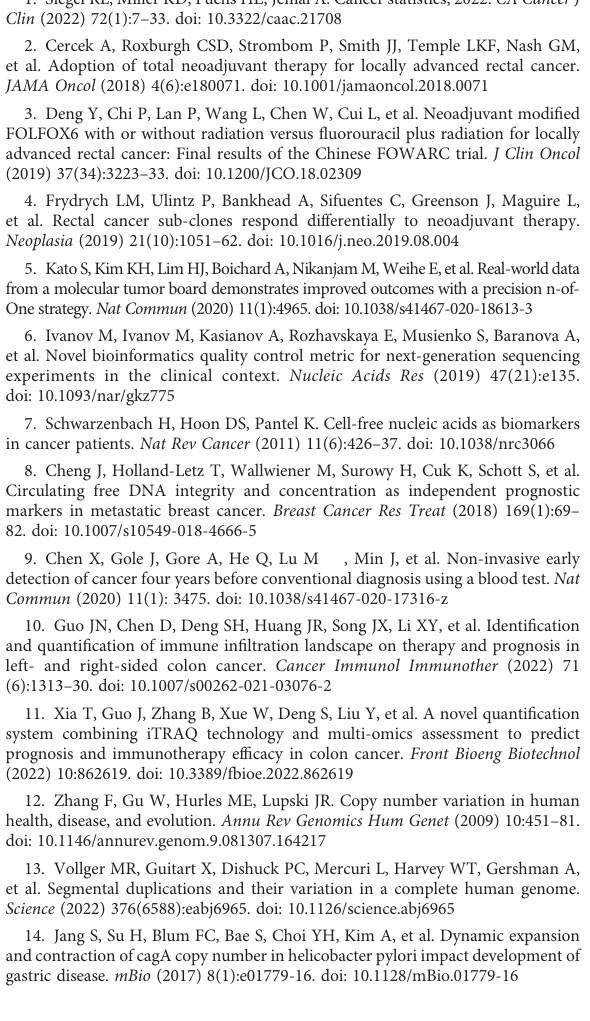
SUPPLEMENTARY FIGURE 2 The changes of RNA expression of the 8 genes identi fi ed from the Venn diagram at different CNV levels, including HSP90AA1 (A) , MDM4 (B) , MTOR (C) , SRC (D) , ARID1A (E) , AURKA (F) , BRAF (G) and EGFR (H) .